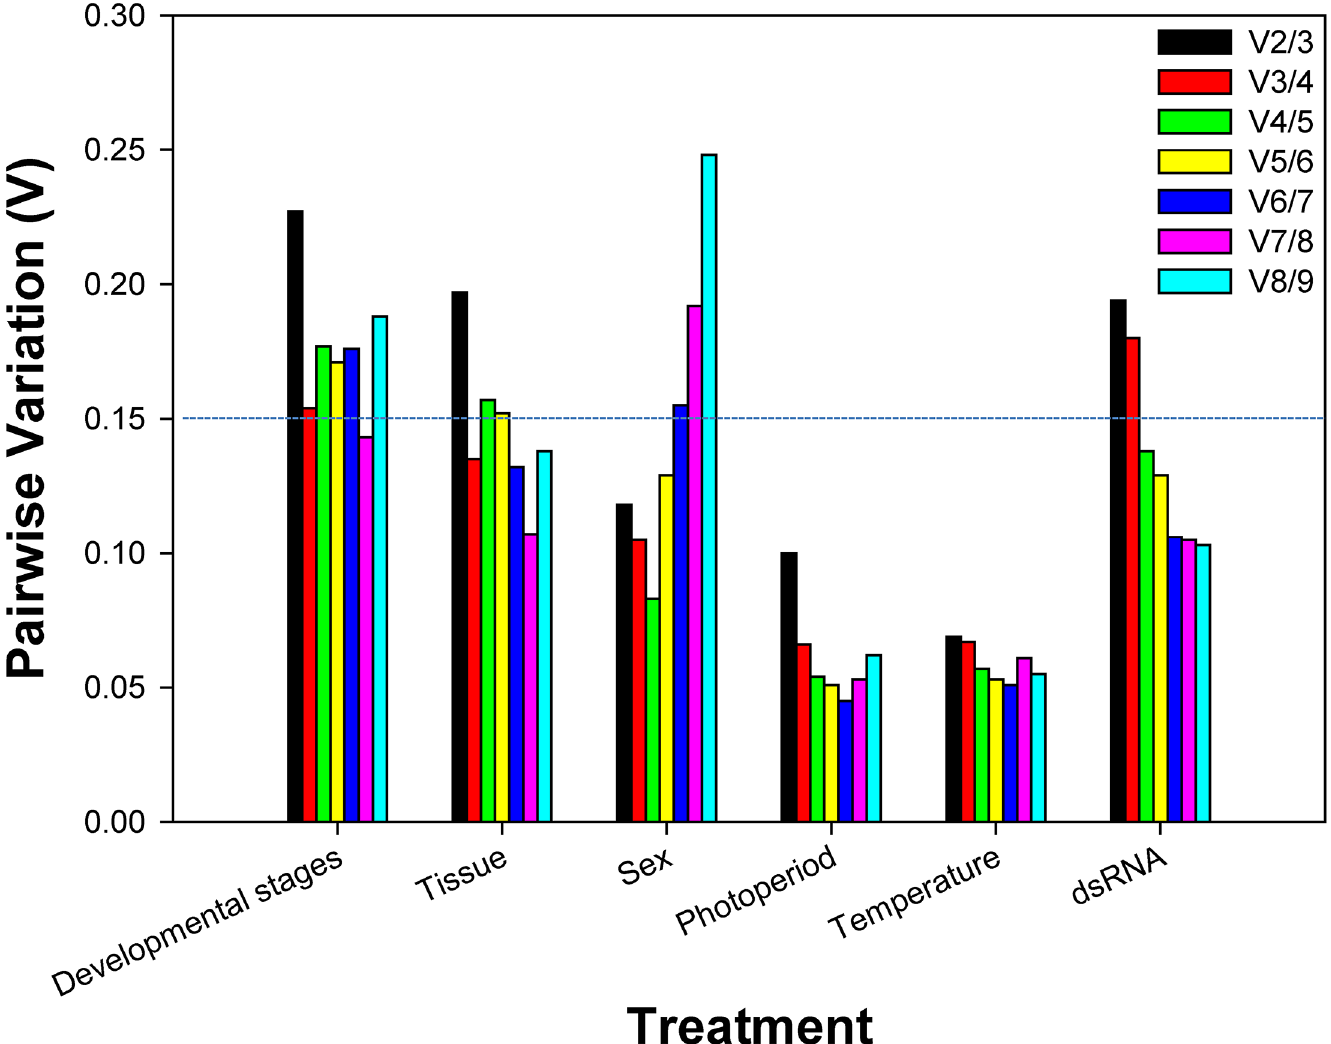
Fig 3. Determination of the optimal number of reference genes. Pairwise variation (V) is an index for determining the optimal number of reference genes for accurate RT-qPCR normalization. A cut-off value for pairwise variation of 0.15 was recommended